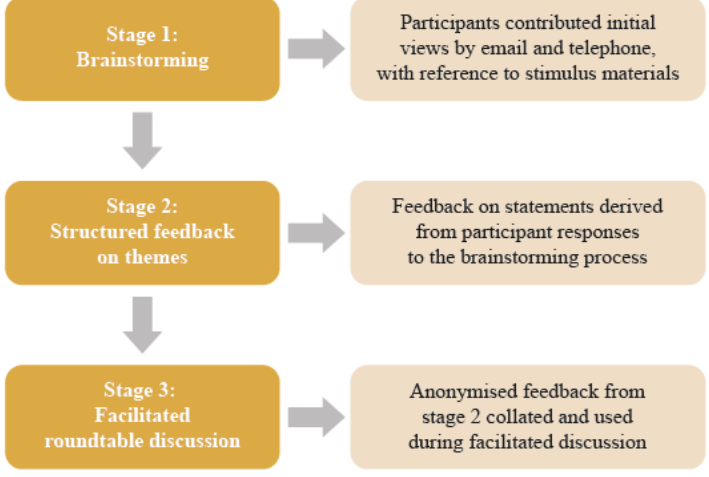
Figure 1. Modified Delphi process.